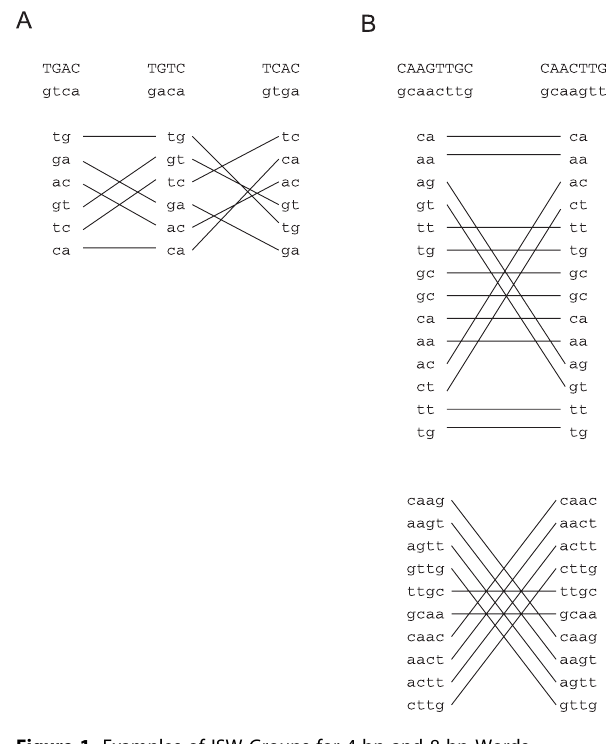
Figure 1. Examples of ISW Groups for 4-bp and 8-bp Words (A) An example of an iso GC/dinucleotide group in 4-bp words. This group consists of the tetranucleotides TGAC, TGTC, and TCAC. In addition to having the same GC content, these words (considering also their reverse complements which are written below them) share the same six dinucleotides. The dinucleotide composition of each word is written below it with lines showing that the same dinucleotides are present in all three words. (B) An example of an iso GC/di/tetranucleotide group in 8-bp words. The two words CAAGTTGC and CAACTTGC have the same GC content as well as sharing the same 14 dinucleotides and the same 10 tetranucleotides.